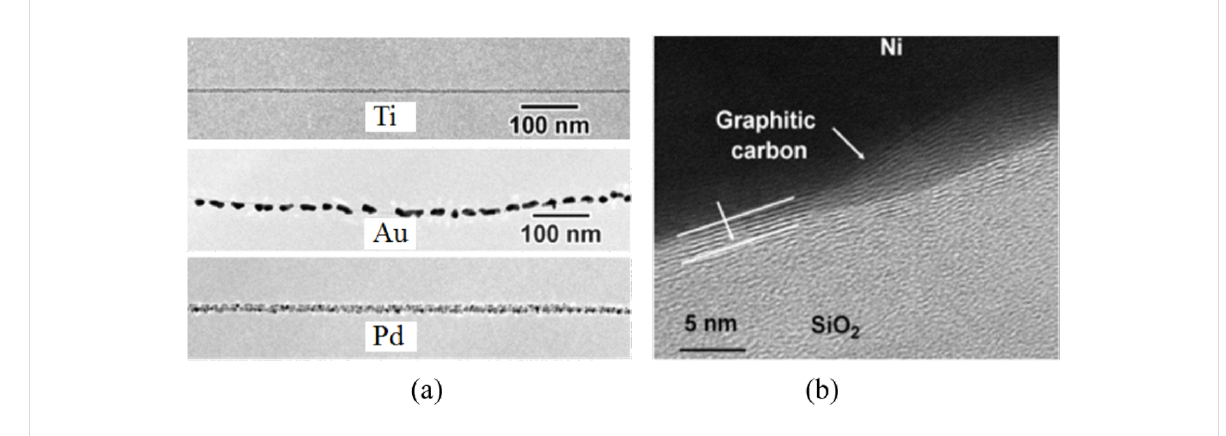
Figure 7: TEM images for (a) metal deposition on suspended, as-grown SWCNTs. Ti displays the best wettability to the SWCNT. Compared to Au, Pd showed better wettability to the SWCNT. (b) The graphitic carbon interfacial layer formed under a Ni layer through annealing treatment. Figure reprinted with permission from (a) [57] copyright 2000 American Institute of Physics and (b) [64] copyright IEEE Electron Devices